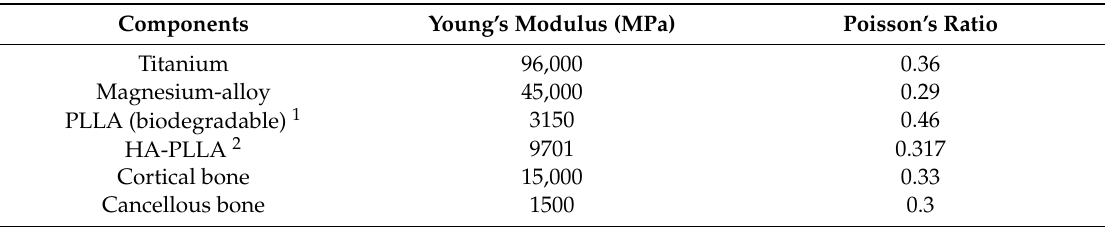
Figure 1. Unilateral angle fracture model of the mandible. Positioning of a four-hole plate and screws is shown at the left mandibular angle, and masticatory loading was applied to the right first molar (non-fractured side). Table 1. Mechanical properties of the materials and mandible for finite element